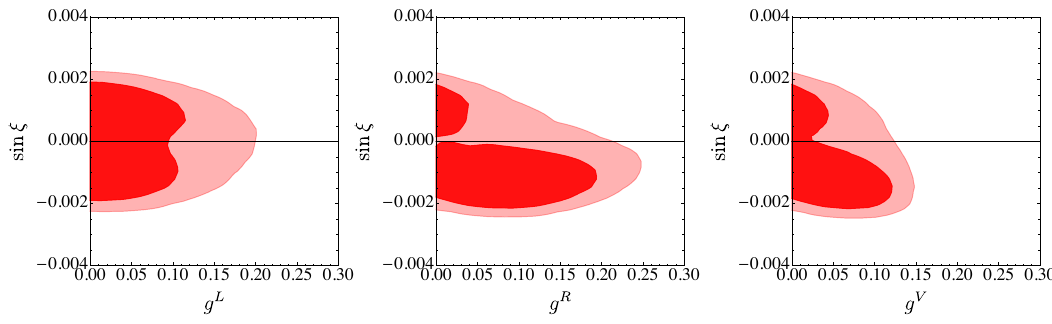
Figure 3. 68% and 95% CL regions for the three LFU cases g L , g R and g V . Note that due to the preference for a slightly lower W mass than predicted in the SM, the origin in the g R scenario is not within the 68% CL region. The Z − Z 0 mixing angle is bounded to be ξ / 0 . 02 and g L,R / 0 . 2 , while g V / 0 . 1 for M = 1 Z 0